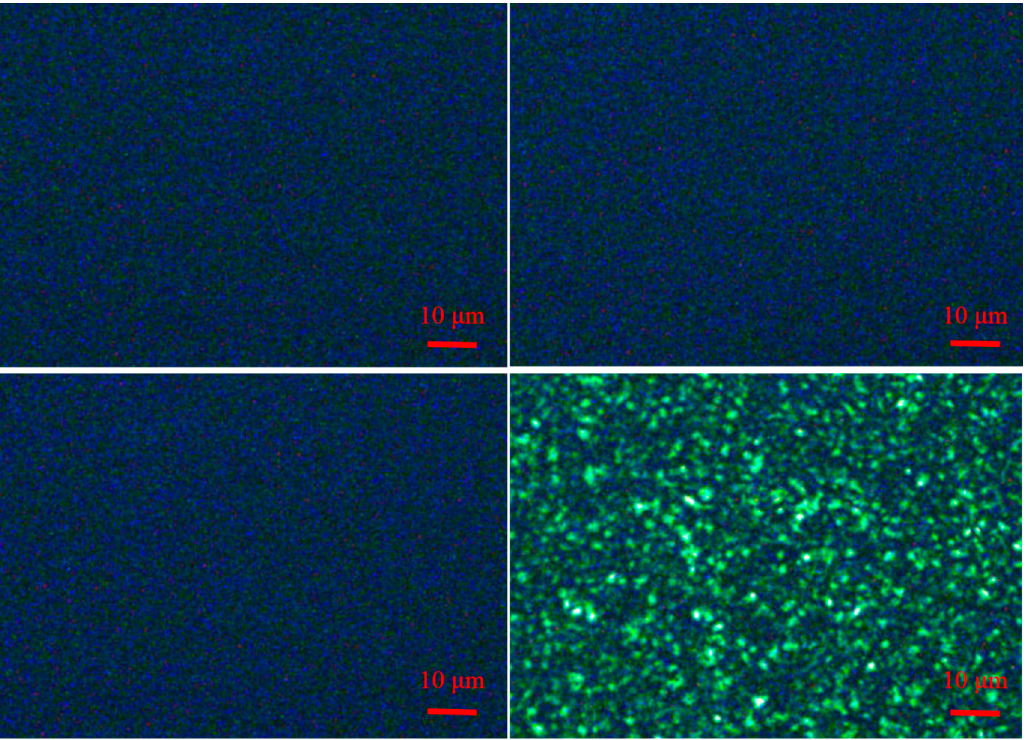
Figure 9. Polarized optical microscope images of PP: a ) PP-1, b ) PP-2, c ) PP-3 with 3000 ppm NX8000, respectively, and d ) PP-1 without the nucleating agent as a comparison. (140 °C, 5min).